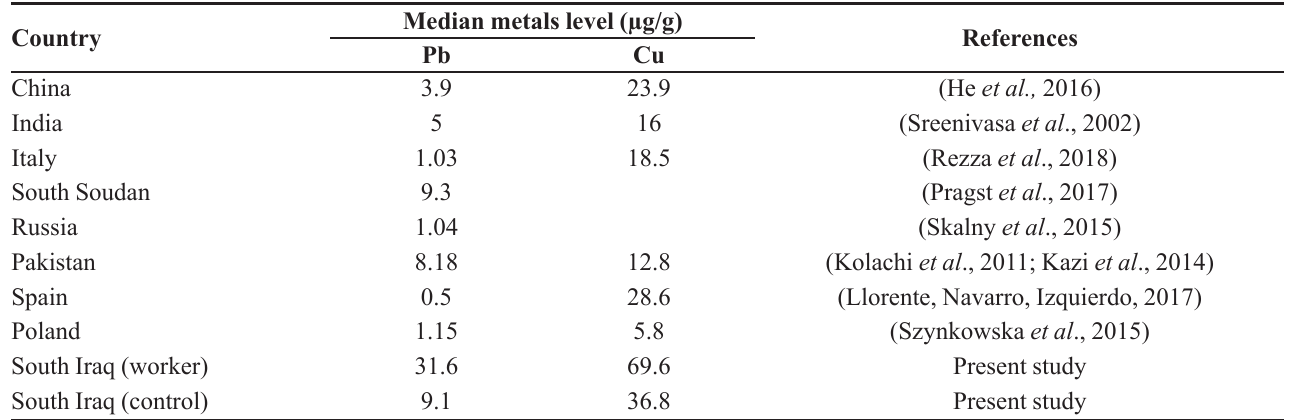
TABLE II - Median levels of Pb and Cu in hair of peoples living in different countries compared to median levels in Iraq